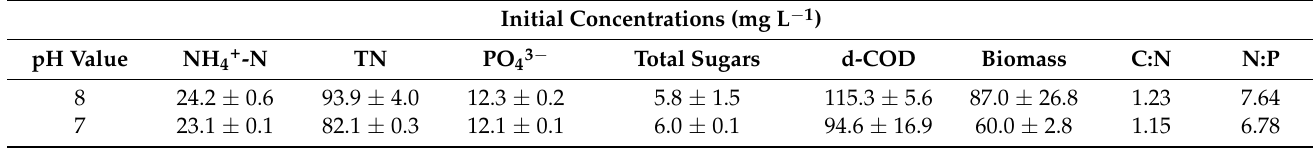
Figure 3. Effect of pH on the biomass production of T. striata . Table 4. Initial biomass and nutrient concentrations at experimental sets for optimum pH investigation.